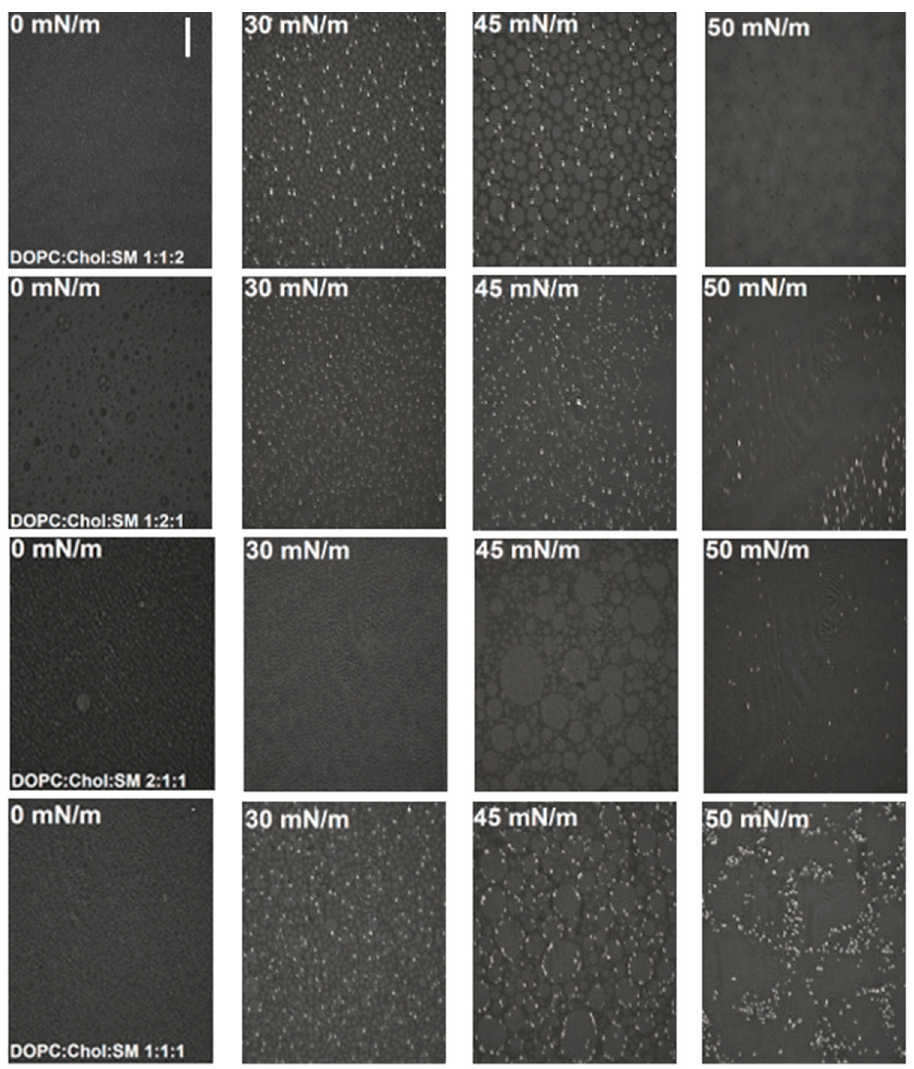
Figure 3. BAM images obtained at selected surface pressures for monolayers of model lipid rafts formed on PBS buffer pH 7.4 (T = 21 ± 1 °C). The scale bar is 100 µm.